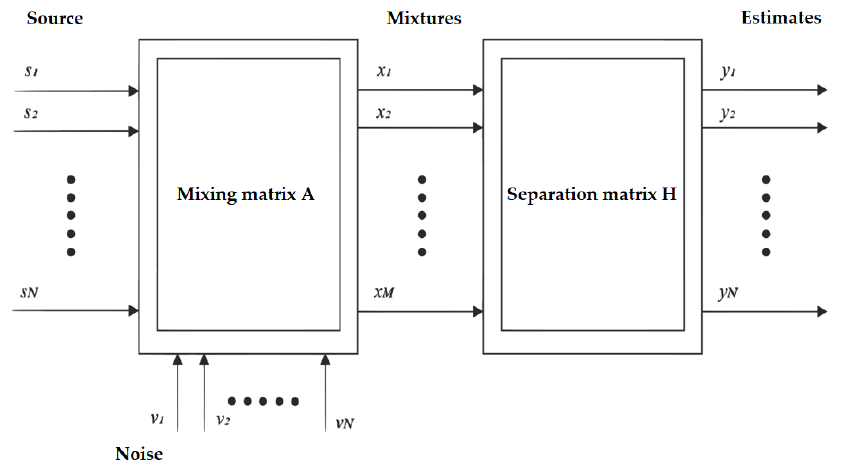
Figure 6. Basic model of the independent component analysis (ICA)